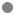
Difference in fibrinolytic properties of plant enzyme and plasmin.
(A) Time course of degradation of fibrin by the plant enzymes and plasmin as observed from SE-HPLC. 1: Fibrin as control (10 μg); 2–4: fibrin (10 μg) treated with the plant extract (0.1 μg) for 4, 12 and 20 hr. 5–7: fibrin under identical conditions of incubation with plasmin (0.1 μg) for 4, 12 and 20 hr. A Protein Pak 300 SW column equilibrated with 10 mM Na-Phosphate, pH 7.5 containing 100 mM NaCl and at a flow rate of 0.8 ml/min was used. In all sets, the elution was followed at 280 nm. (B-C) time course of degradation of fibrin by the plant enzymes and plasmin as observed in SDS-PAGE. (B) lane 1, plant extract (0.01 μg); lanes 2–8, fibrinogen (10 μg) treated with the plant extract (0.01 μg) for 0, 1, 2, 3, 4, 5 and 6 hr respectively. (C) lane 1, plasmin (0.01 μg); lanes 2–8, fibrinogen (10 μg) treated with plasmin (0.01 μg) for 0, 1, 2, 3, 4, 5 and 6 hr respectively. (D) Time course of amidolysis of S-2251 (0.08 μM) in presence of plasmin (10 μg) (■) and plant enzyme (20 μg) (●); (E) Amidolytic assay for plasminogen-like activity of the plant extract (100 μg) in presence plasminogen (60 μg) (●). Plasminogen (60 μg) in presence of urokinase (10 μg) (■) served as control. Spontaneous hydrolysis of S-2251 was insignificant and has not been included to ensure clarity.